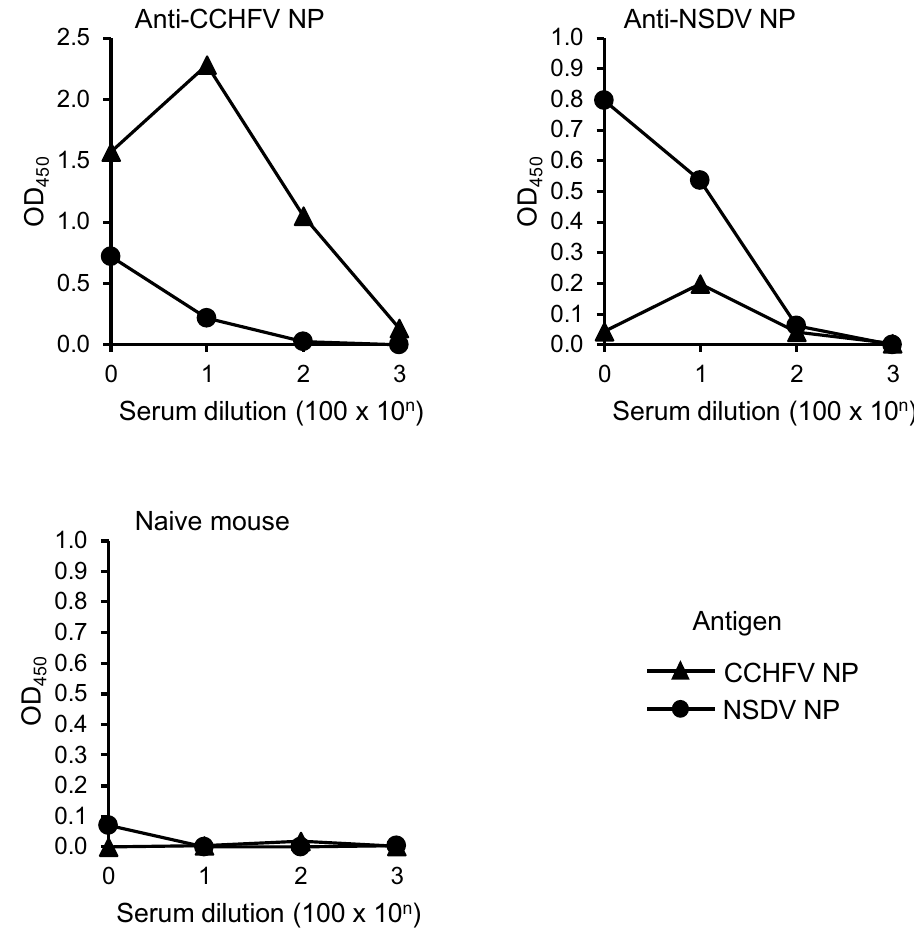
Figure 7. Cross-reactivity of antisera to CCHFV and NSDV NPs. ELISA plates were coated with 10 µg/ml of purified CCHFV NP, NSDV NP, or the mock antigen. Serial dilutions (1:100, 1:1,000, 1:10,000, and 1:100,000) of mouse antiserum to CCHFV, to NSDV NP, and naïve mouse serum were used as primary antibodies and incubated for 2 h at 4 °C. Peroxidase conjugate goat anti-mouse IgG (H + L) was used for detection of bound antibodies. To offset the nonspecific antibody reaction, the OD value of the mock antigen was subtracted for each